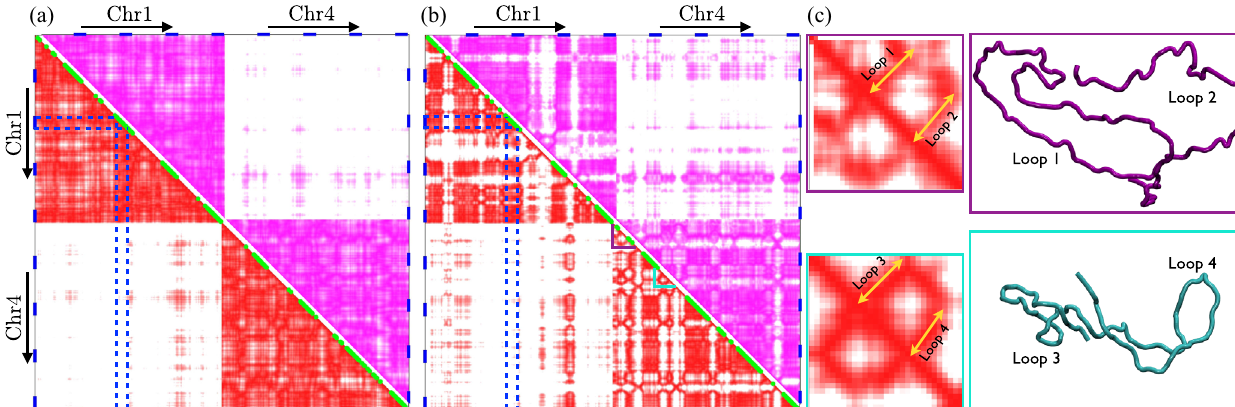
FIG. 5. Hi-C proximity maps for (a) a passive euchromatin system ( σ 0 ¼ 0 ) and (b) an active euchromatin system (extensile, σ 0 ¼ 30 ); see Appendix B for details of the method. The maps show chromosomes 1 and 4 that were not in direct contact in the initial condition [pink and orange chains in Fig. 2(d)]. In each case, the lower diagonal (red) shows a time snapshot, whereas the upper diagonal (pink) shows an average over t ∈ ½ 350 ; 700 (cid:2) . Blue segments along the axes indicate the HC blocks (four per chromosomes), which are the locations where cross-links can form. Green segments along the diagonal show sections of the chain that are spatially contained inside the HCRs identified in Fig. 2(c). (c) Two examples of loops forming inside euchromatin in the extensile case and an enlargement of their signature in the Hi-C map of (b), where their location is highlighted by purple and cyan triangles along the diagonal of chromosome 4 in (b). These panels use the data from the simulations in Fig.